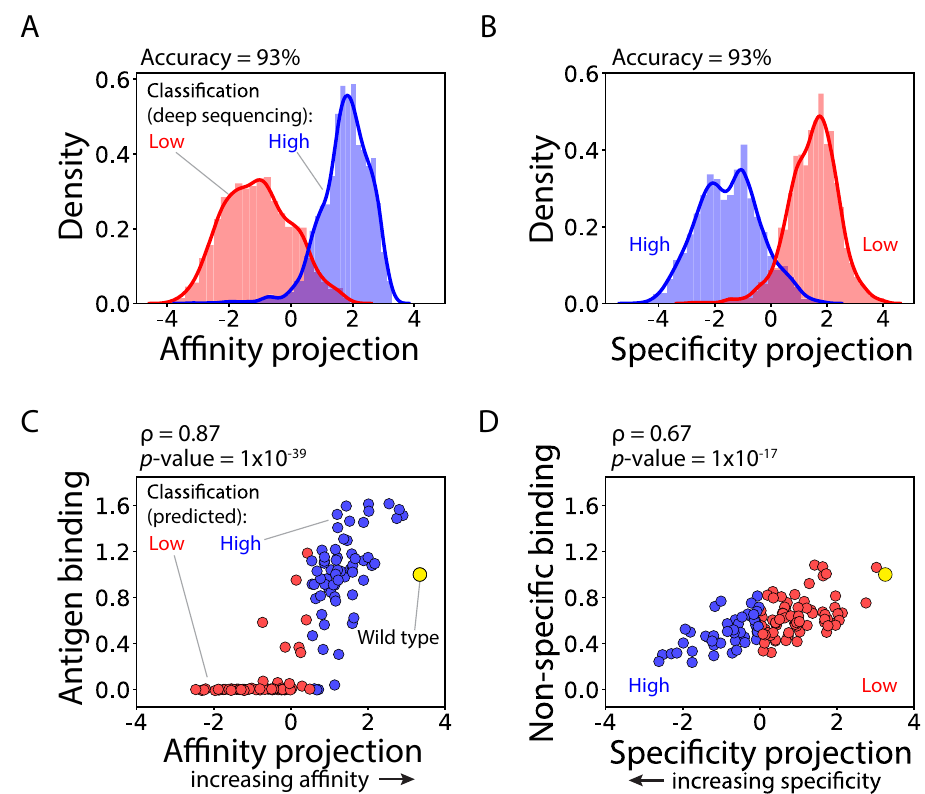
Fig. 3 Models trained using supervised dimensionality reduction not only accurately classify antibody mutants with high and low levels of af fi nity and speci fi city but also accurately predict intraclass variability. A , B Linear discriminant analysis (LDA) models were trained using sequence-based features (one-hot encoded sequences as binary vectors) and displayed high accuracy for classifying antibody af fi nity and speci fi city for 4000 antibodies identi fi ed in the enriched libraries via deep sequencing. (C-D) The continuous predictions of the LDA models, which are referred to as projections, are strongly correlated with experimental measurements of the ( C ) relative af fi nity and ( D ) non-speci fi c binding for 125 single-chain antibodies (Fabs) selected randomly from the sorted libraries. In ( C ), the antigen (HGFR) concentration was 1 nM, and the values are normalized between elotuzumab (value of zero) and wild-type emibetuzumab (value of one). In ( D ), the non-speci fi c binding reagent was ovalbumin (0.1 mg/mL). In ( A – D ), the projection (x-axis) values that separated high and low classes (e.g., high and low af fi nity) were close to but not exactly zero. In ( C ) and ( D ), the experimental measurements are averages of two or three independent repeats. Independent two-sided t -tests were performed to determine signi fi